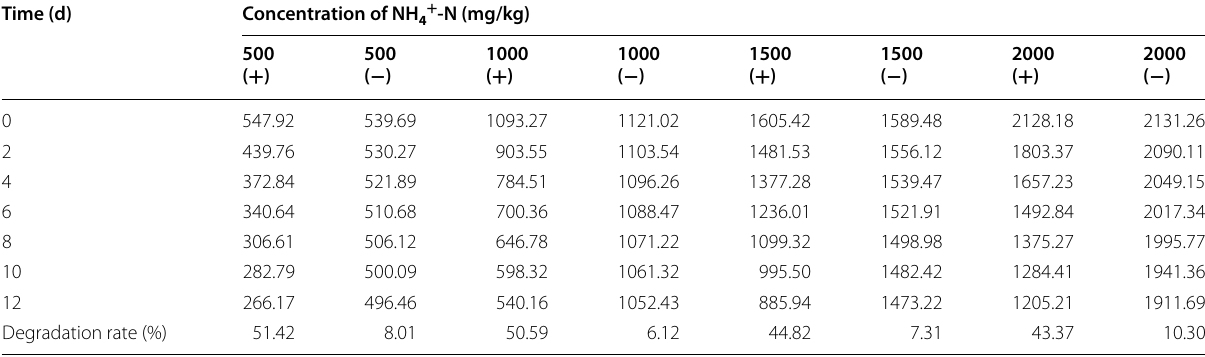
The concentrations of NH 4 + -N are presented as the average values of two determinations d, day; ( ), without Gan-35; ( ), with − +